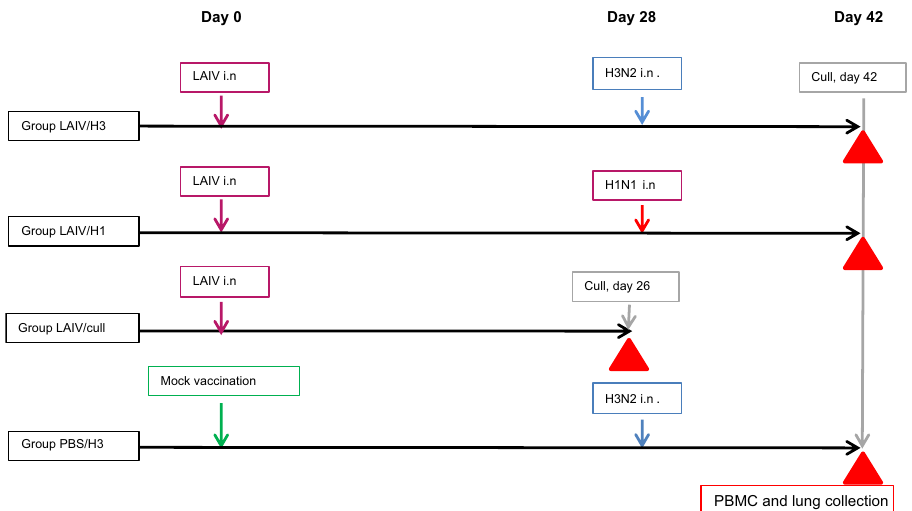
Fig. 1 Outline of study design. Blood samples for serum and antigen stimulation, and nasal washes, were collected as described in “ Methods ”